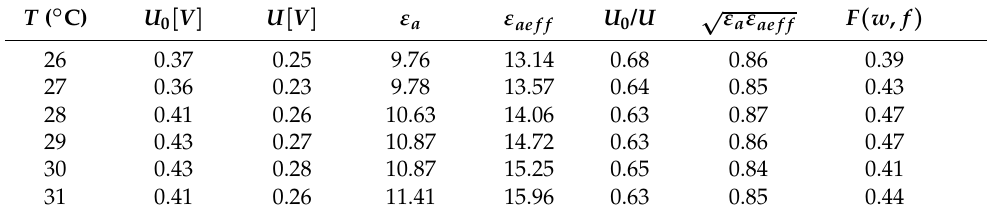
Table 1. Electric Freedericksz transition threshold for 7CB ( U 0 ) and for 7CB + MWCNTs (U).